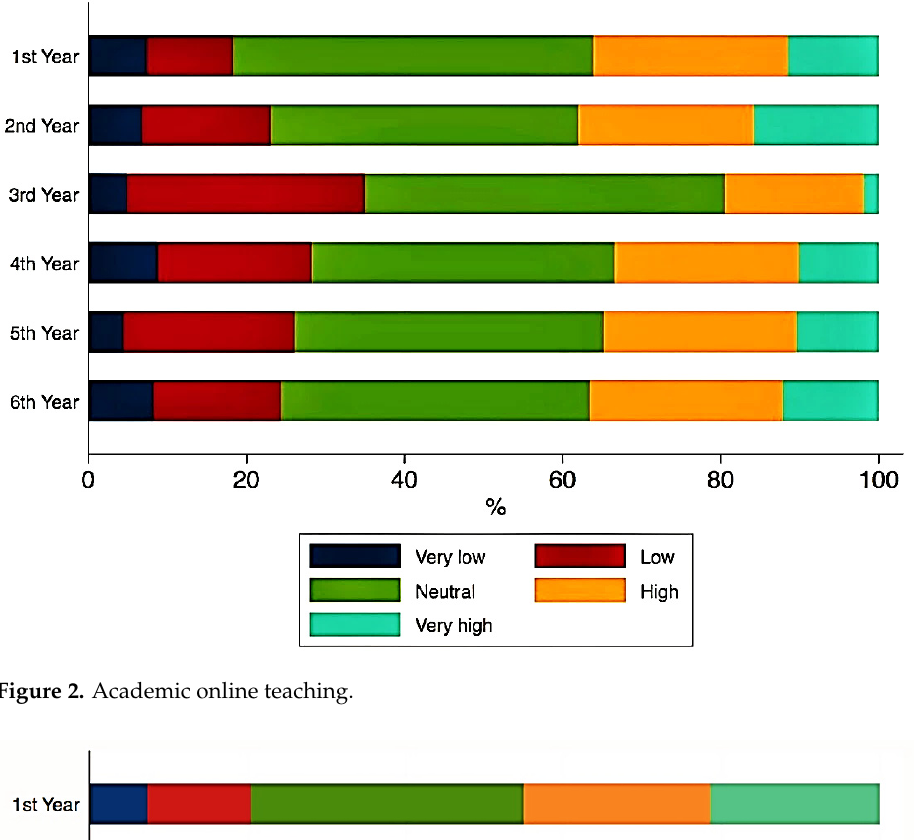
Figure 1. Academic online learning.